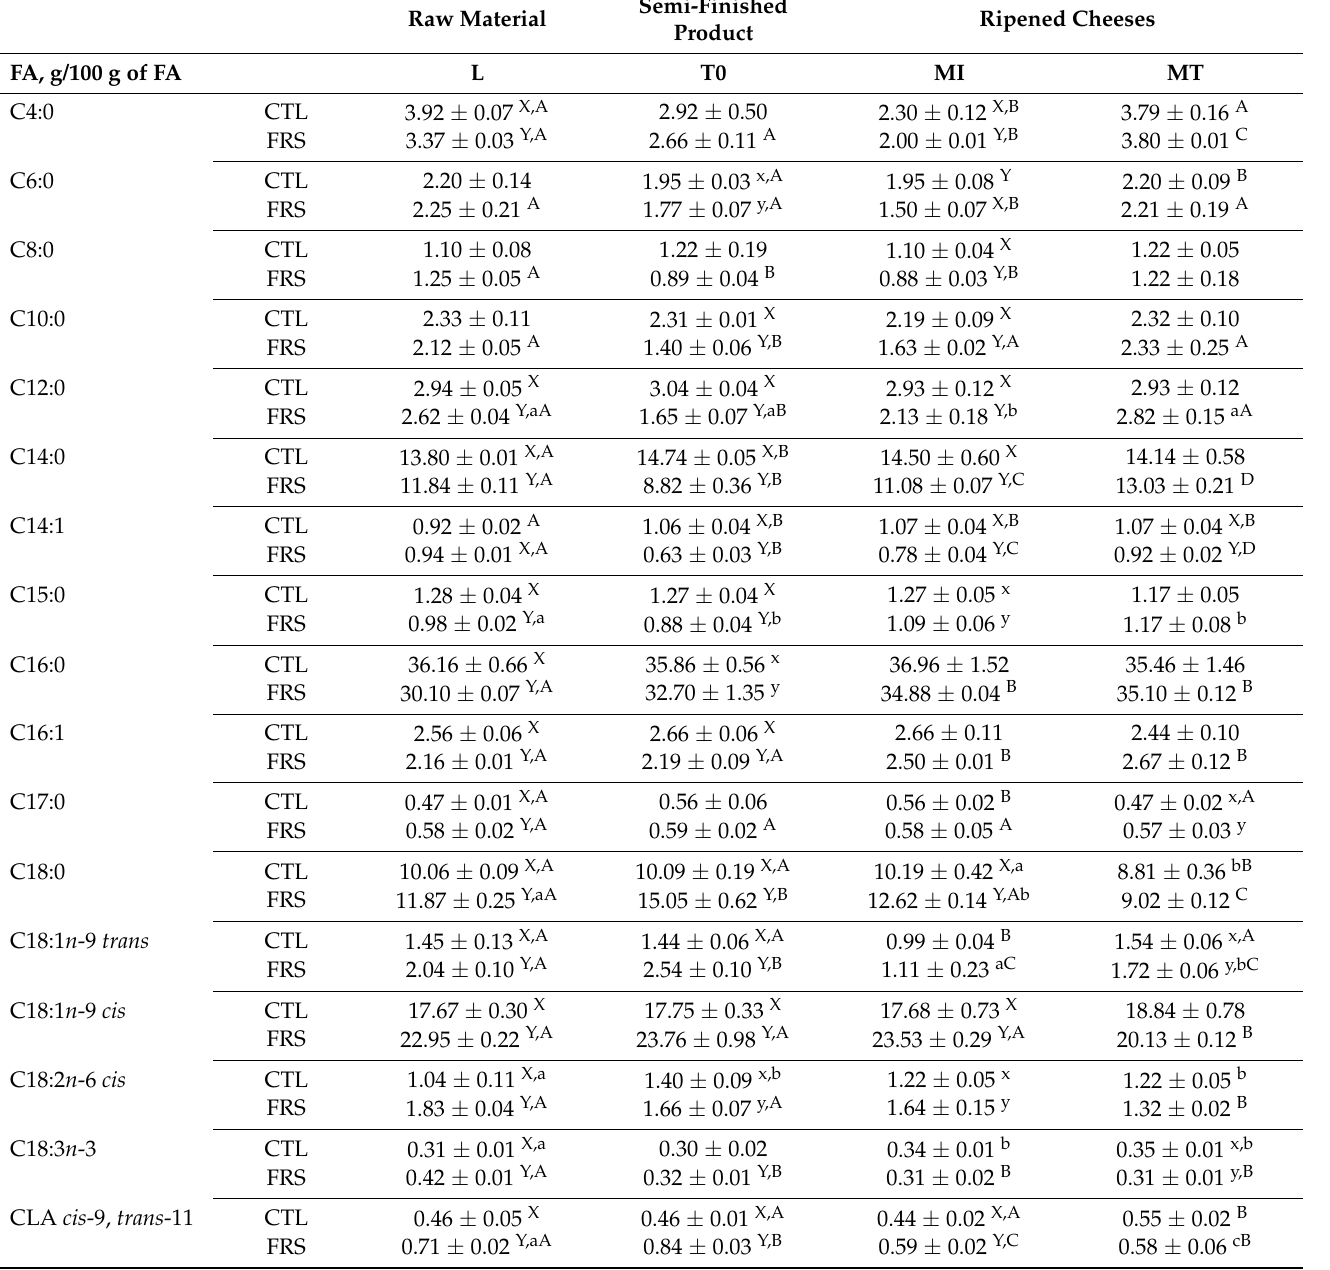
Table 7. Effects of feeding system and ripening time on fatty acid profile of dry ricotta